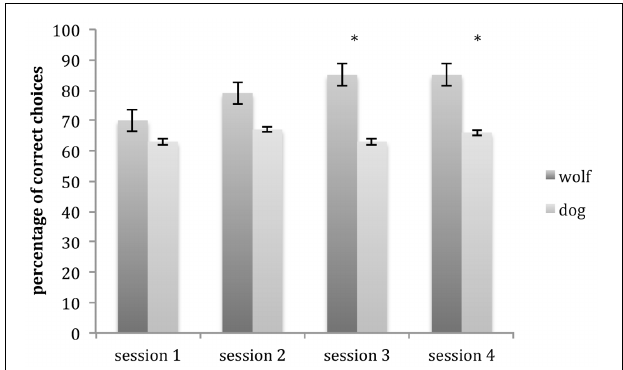
FIGURE 3 | Mean number of correct choices (and SE) carried out by wolves and dogs in comprehension trials for each session. Wolves outperformed dogs in sessions 3 and 4. ∗ p < 0.001.